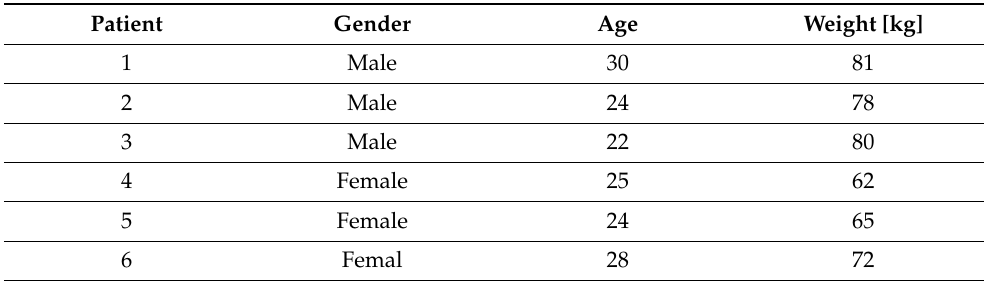
Table 3. Summary table reporting the information related to the patients involved in the chest band tests.